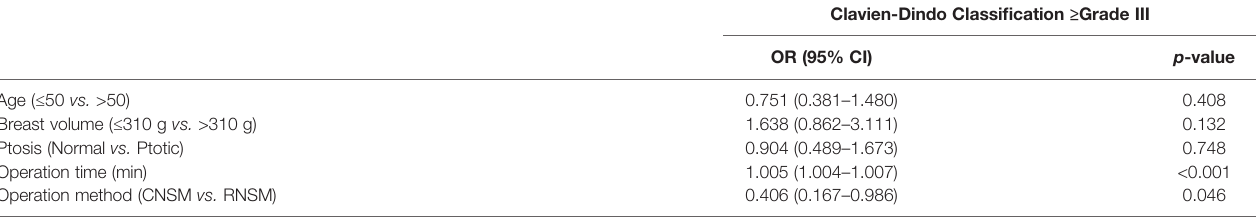
TABLE 3 | Multivariate analysis for risk factors related with high-grade complications.